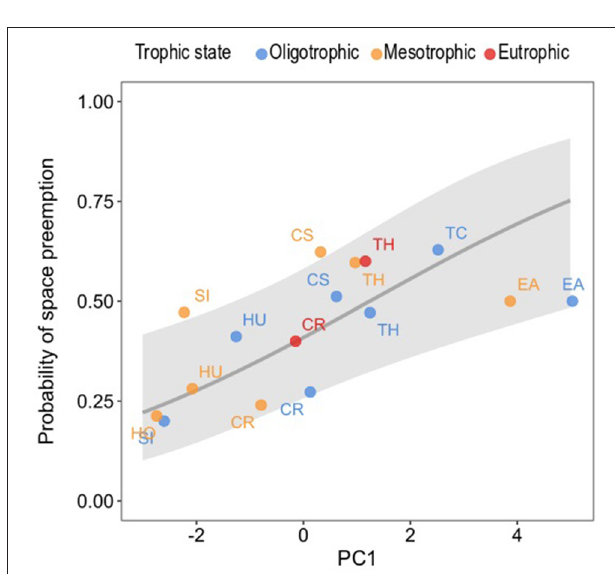
FIGURE 9 | Probability of preemption of all seagrass species present in the studied meadows in Unguja Island as explained by their scores in PC1. Each data point is the score of the seagrass species in a trophic state, coded by their corresponding colors, and the letters are the seagrass species. The gray line is the fitted line and the gray ribbons the confidence intervals of the p i = − 0.367 + 0.296 PC 1. prediction of preemption. Model equation: ln 1 − p i (cid:17) (cid:16) Seagrass species: CR, C. rotundata ; CS, C. serrulata; EA, E. acoroides ; HO, H. ovalis ; HU, H. uninervis ; SI, S. isoetifolium ; TC, T. ciliatum ; TH, T. hemprichii